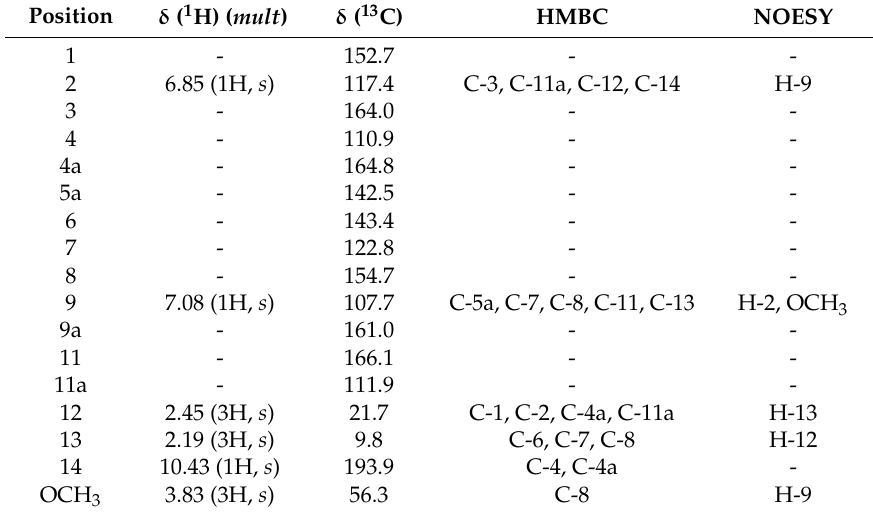
Table 2. NMR spectroscopic data (500 MHz for 1 H and 125 and 200 MHz for 13 C, in CDCl 3 ) of compounds 14 and 15 ( δ in ppm and J in Hz). 14 15